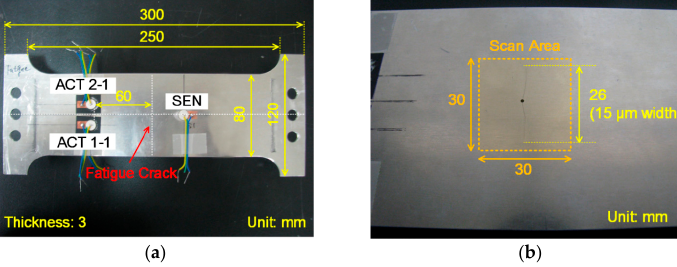
Figure 1. Aluminum plate specimen. ( a ) The geometry and dimensions; ( b ) A close-up of the fatigue crack.